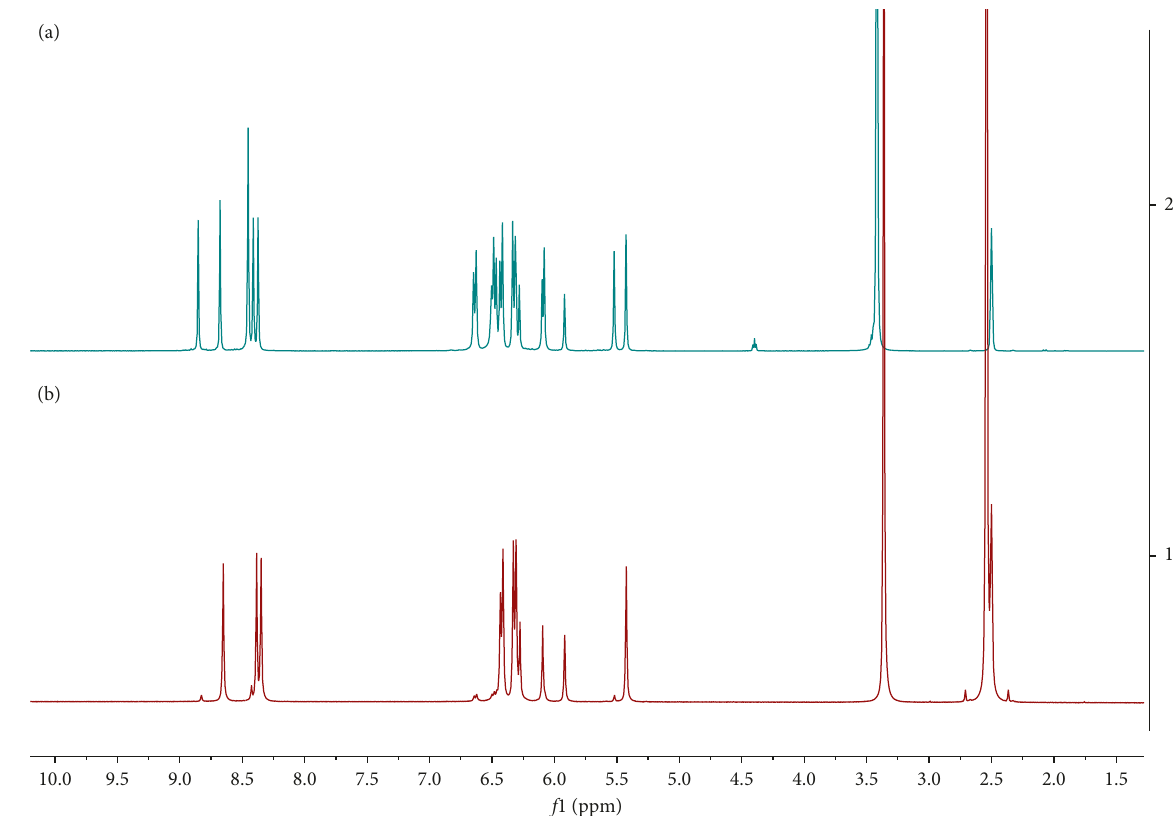
Figure 2: 1 H-NMR spectra to 400 MHz, DMSO- d 6 , and 293K. (a) Conformational mixture. (b) Chair